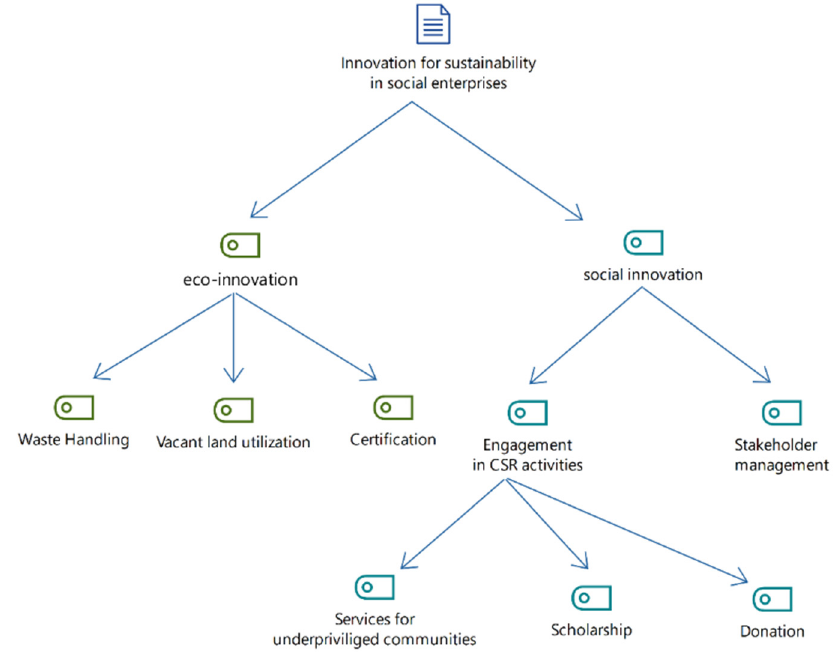
Figure 1. Map of Figure 1. Map of themes.